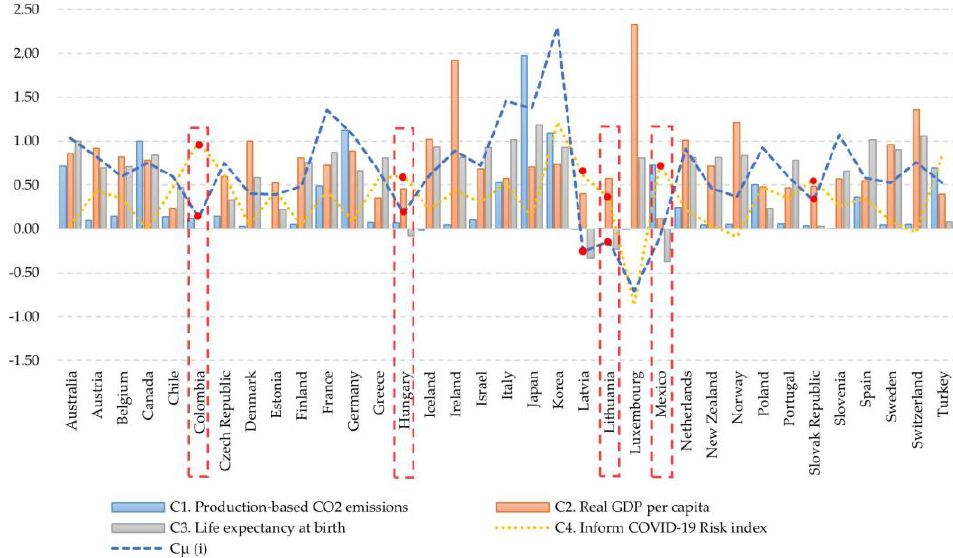
Figure 1. Evolution of the research nations’ sustainability levels in respect to their own risk tolerance according to COVID-19. Examples of a strong relationship between territorial riskiness and sustainability are given.